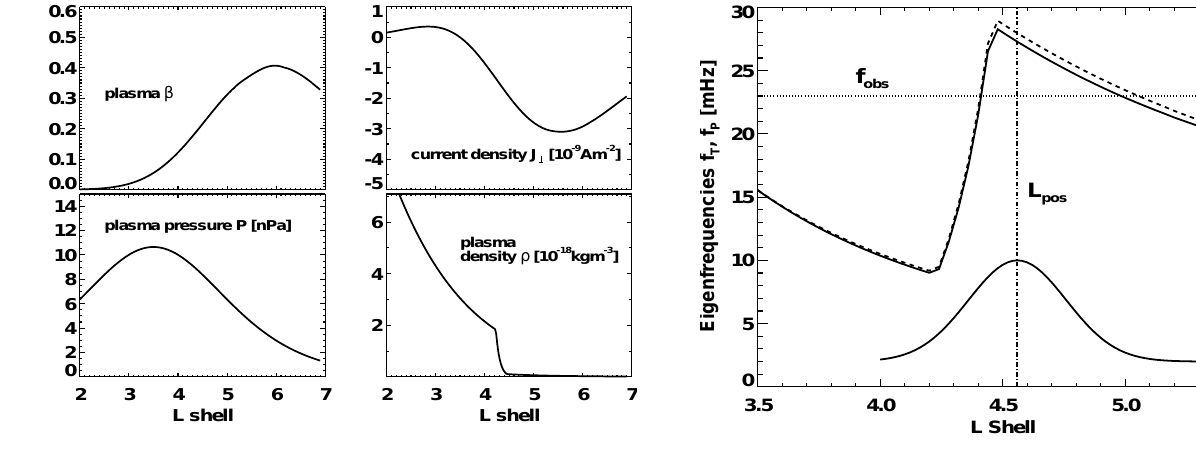
Fig. 14. Radial profiles of wave amplitude at time t 4 and toroidal (solid line) and poloidal (dashed line) field line eigenfrequencies, each for the second longitudinal harmonic. The dotted line marks the observed frequency f obs = 23 mHz, the dot-dashed line marks the L shell of maximum amplitude and phase jump L pos = 4 .